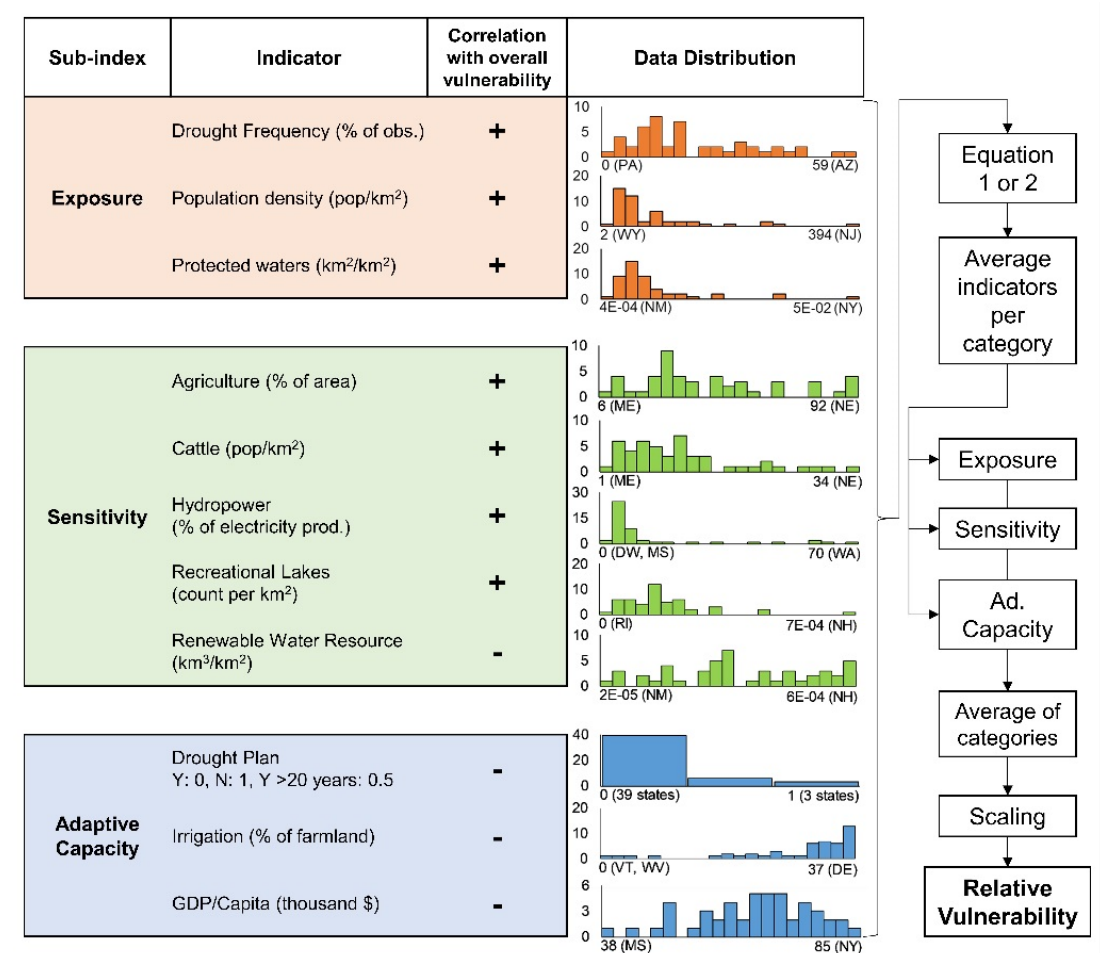
Figure 1. The indicators used in the analysis, grouped into their respective sub-indices, Exposure, Sensitivity, and Adaptive Capacity. The correlation sign with the overall relative vulnerability is also noted. The distribution of the indicator data is shown in color-coded histograms, with the y-axis representing the number of states in each bin. The histograms also show the min and max value for each indicator and from what state the extreme values originate. The indicator data are then entered into Equation (1) or (2) for normalization, and the normalized data are then averaged by category, resulting in the sub-indices. In the final step, the three sub-indices are averaged and scaled to become the overall Relative Vulnerability score. An overview of the calculation procedure can be seen on the right-hand side of this